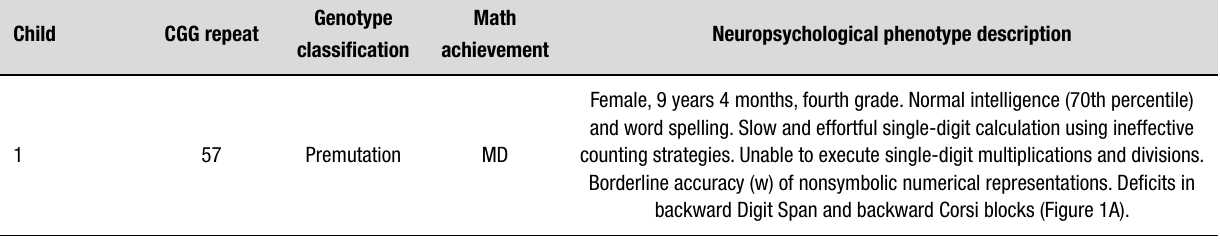
Table 4. Genotype and phenotype characteristics of children with expanded FMR1